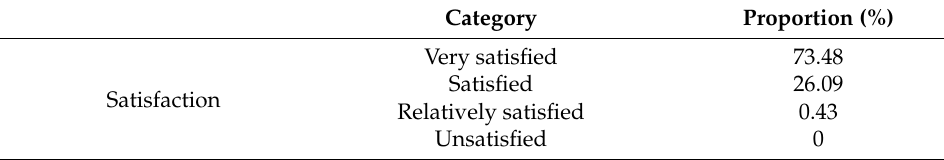
Table 2. Life satisfaction of peasant households with valid questionnaires.